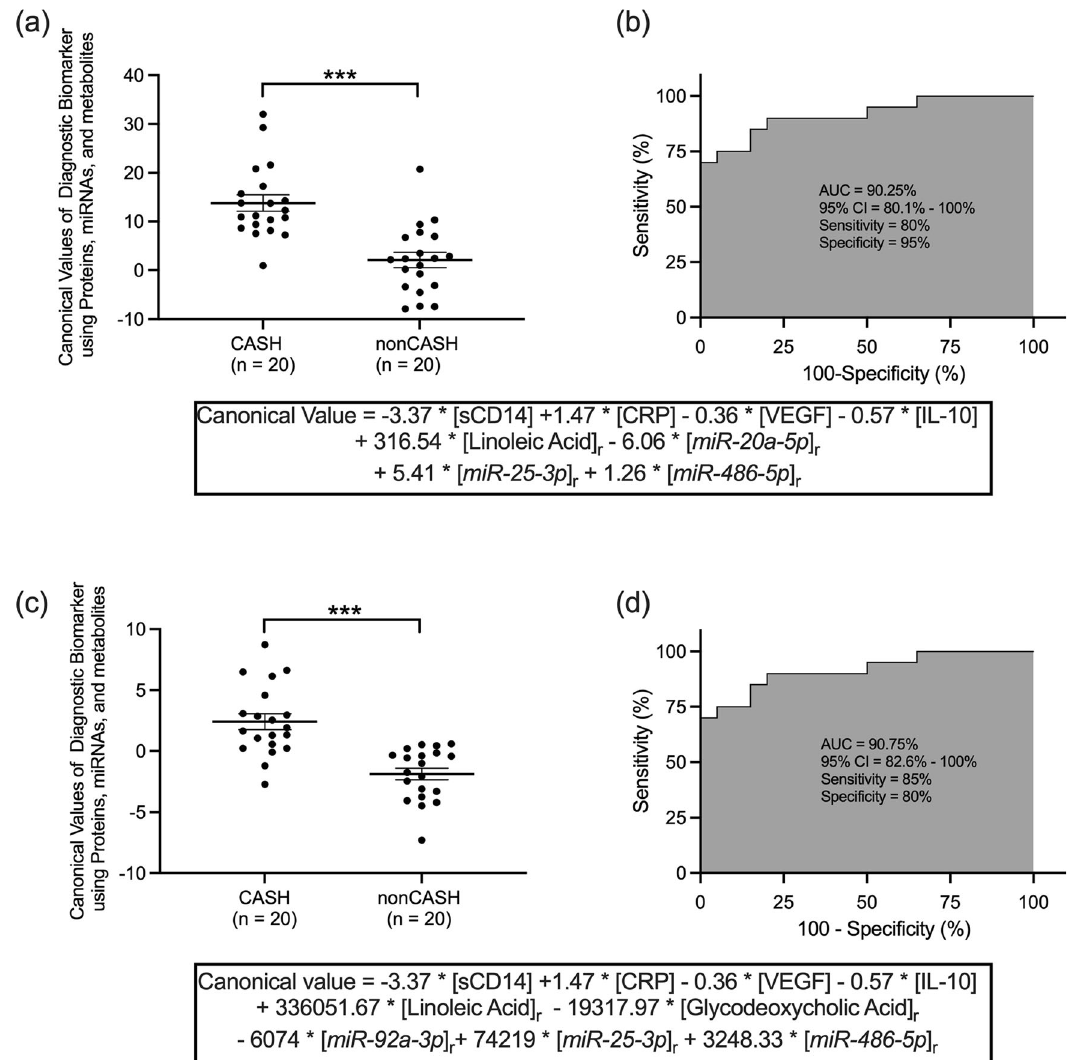
Fig. 5 Weighted combinations of plasma ratio of metabolites and micro-RNAs (miRNAs) improve the performance of the proteins-based cavernous angioma with symptomatic hemorrhage (CASH) biomarker. The canonical values estimated with the optimal integrative weighted model were ( a ) higher (unpaired Student ’ s t test, p < 0.0001) in the CASH ( n = 20 biologically independent patient samples) compared with cavernous angioma without symptomatic hemorrhage (non-CASH) patients ( n = 20 biologically independent patient samples) included in the independent propensity matched validation cohort. b The receiver operating characteristic (ROC) analyses showed that this integrative model differentiated CASH patients from non-CASH patients with 80% sensitivity and 95% speci fi city (area under the curve [AUC] = 90.25%). c An alternative optimal integrative weighted model developed using a parallel 10-fold cross-validation machine learning approach showed higher canonical values higher (unpaired Student ’ s t test , p < 0.0001) in CASH compared with non-CASH patients. d The ROC analysis showed that the alternative optimal integrative model differentiated CASH from non-CASH with 85% sensitivity and 80% speci fi city (AUC = 90.75%). CI, con fi dence interval; *** p < 0.001. Error bars re p resent standard error of the